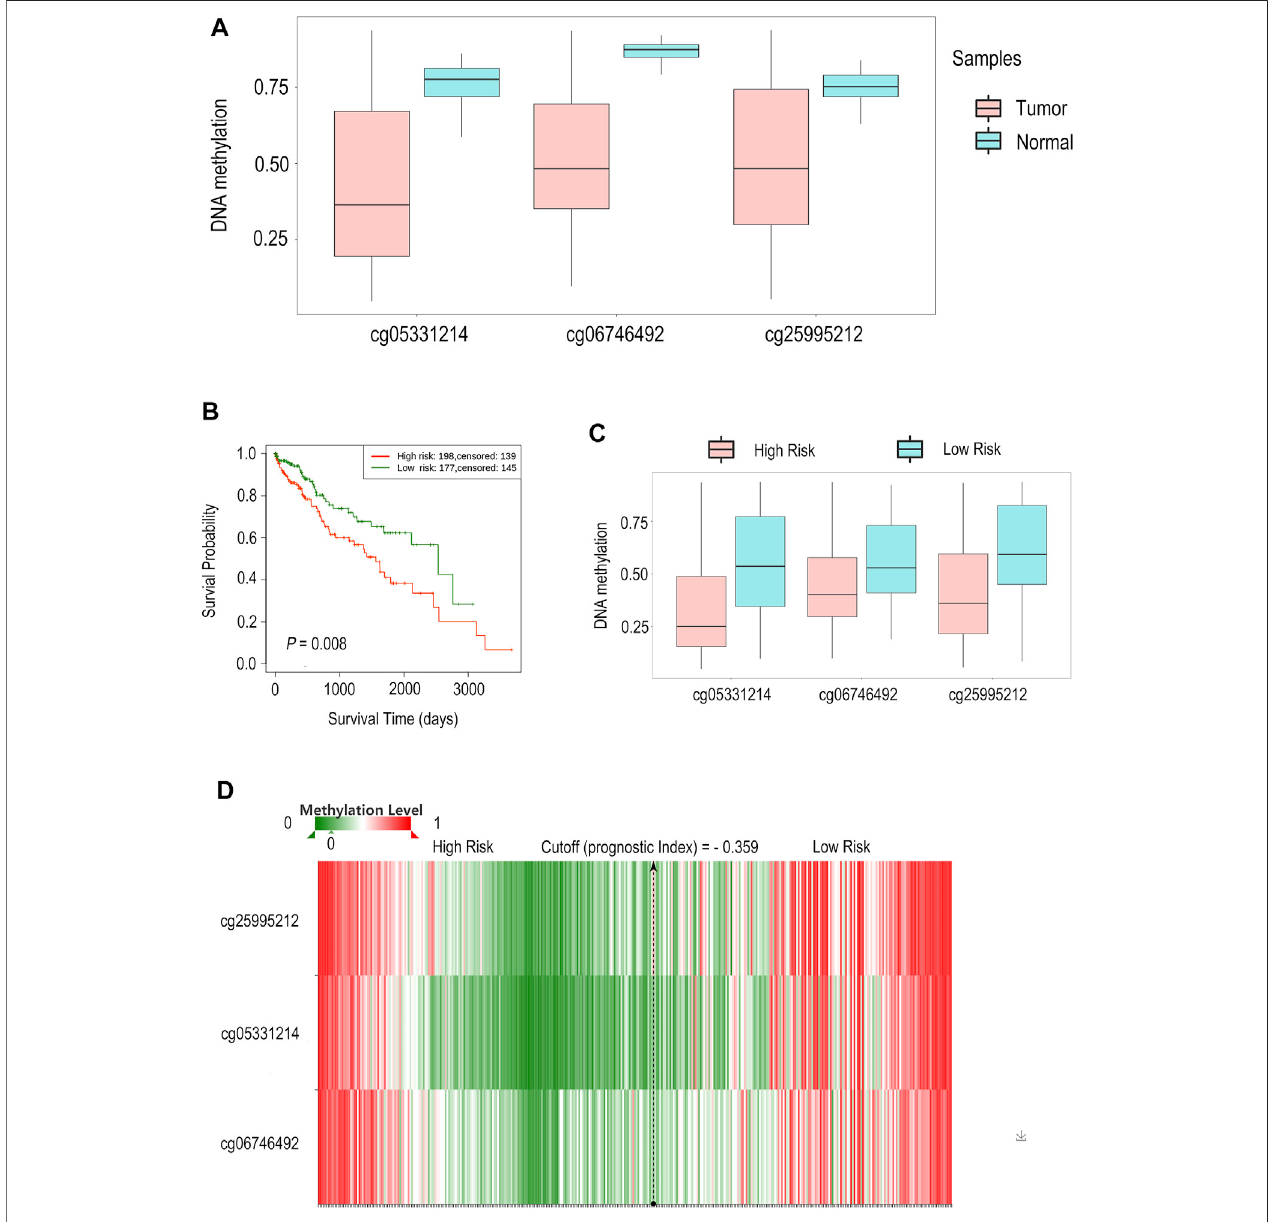
FIGURE 6 | The DNA methylation level of SCN7A and its prognostic value in HCC by SurvivalMeth. (A) A lower SCN7A DNA methylation level with all probes was shown in HCC tumour tissues. (B) The high-risk group of HCC patients had poor outcomes. (C) The High-risk group had lower methylation levels of CpGs. (D) The methylation level of CpGs is shown in the hierarchical clustering